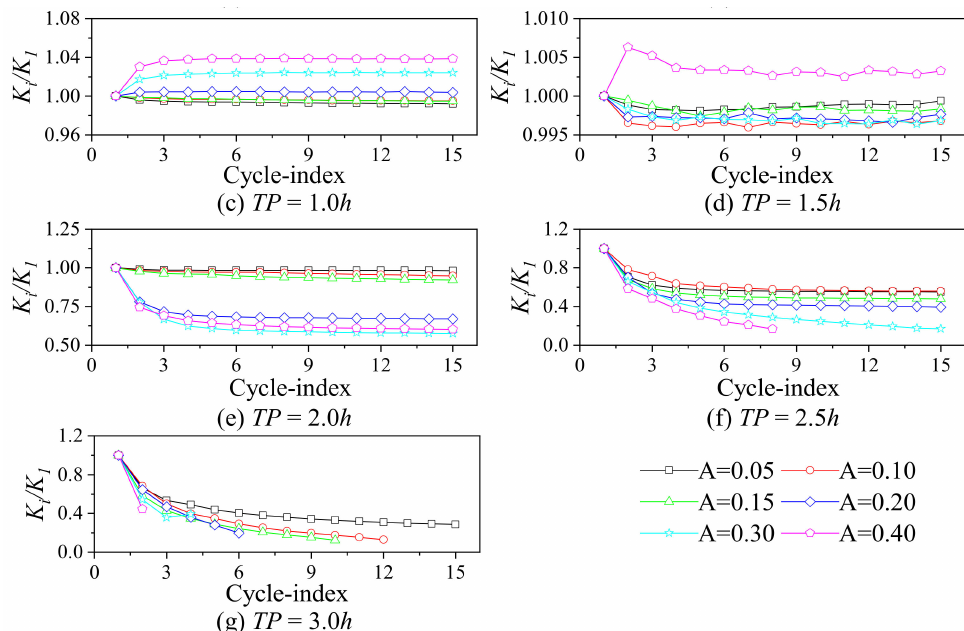
Figure 15. Variation curve of stiffness degradation ratio ( K i / K 1 ) with cycle index under different working conditions.